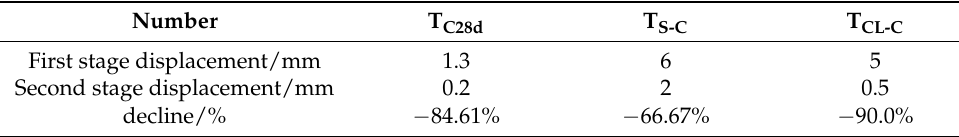
Table 4. Change of the critical